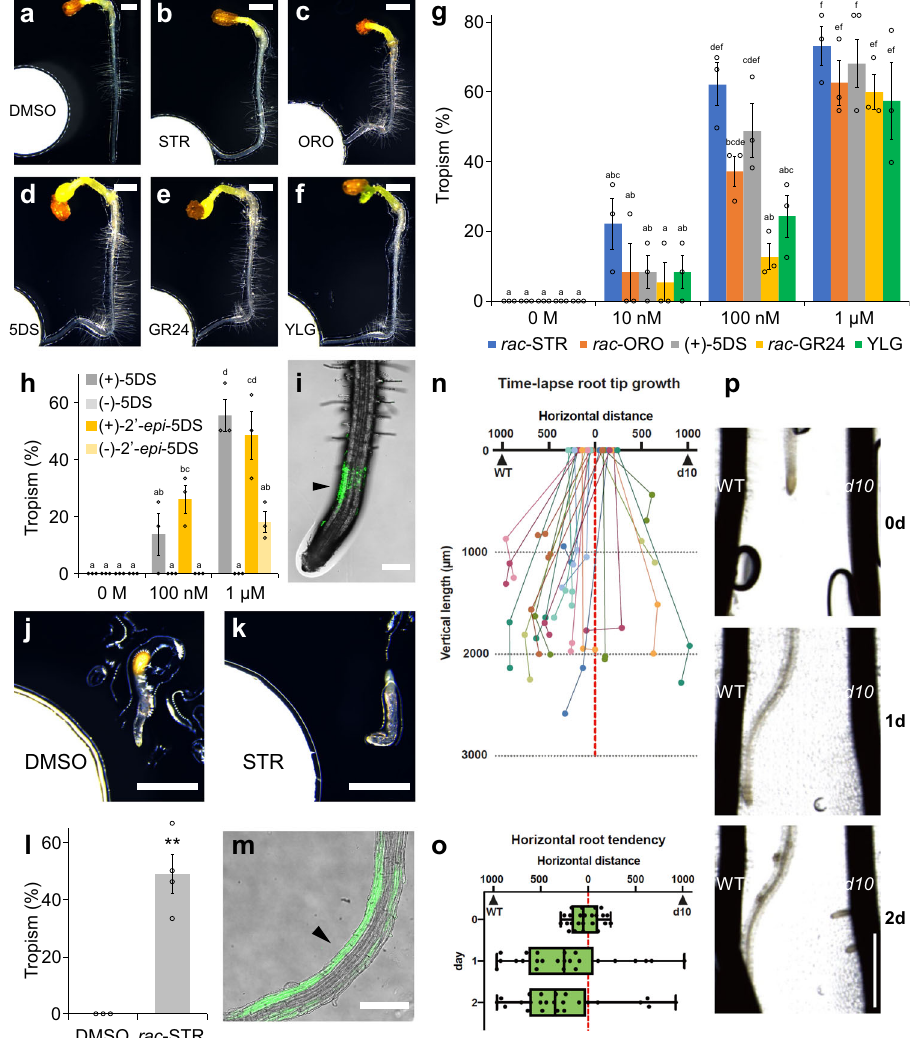
Fig. 1 | Chemotropic phenotype of Orobanchaceae parasitic plants to SLs and analogues. a – f Representative images of P. japonicum seedlings treated with 1 µ M chemicalsolutions diluted in 0.1% DMSO. Photosweretaken 1 day after treatment. a 0.1% (v/v) DMSO; b rac -strigol (STR); c rac -orobanchol (ORO); d (+)-5DS; e rac - GR24; f YLG. g , h Percentage of P. japonicum plants that showed chemotropism to each chemical. Three independent batches (3 – 12 and 4 – 8 seedlings in each batch for g and h , respectively) for each compound. i A representative image of P. japonicum exhibiting YLG-derived fl uorescence after treatment with a 100 µ M YLG solution. Filter paper disks were placed 5-mm to the left of the roots. Confocal photosweretaken6haftertreatment. j , k Representativeimagesof S.hermonthica seedlings treated with 1 µ M rac -strigol or 0.1% (v/v) DMSO solutions. Photos were taken 1 day after treatment. Eighteen out of 22 plants showed a similar fl uorescent pattern. j 0.1% DMSO; k rac- strigol. l Percentage of S. hermonthica plants that showedchemotropismto1 µ M rac -strigol.Threeorfourindependentbatches(2 – 13 plants) were treated with each compound. m A representative image of S. her- monthica exhibiting YLG-derived fl uorescence when treated with a 100 µ M YLG solution. Filter paper disks were placed 3-mm to the left of the roots. Confocal photos were taken 24h after treatment. Thirteen out of 16 plants showed a